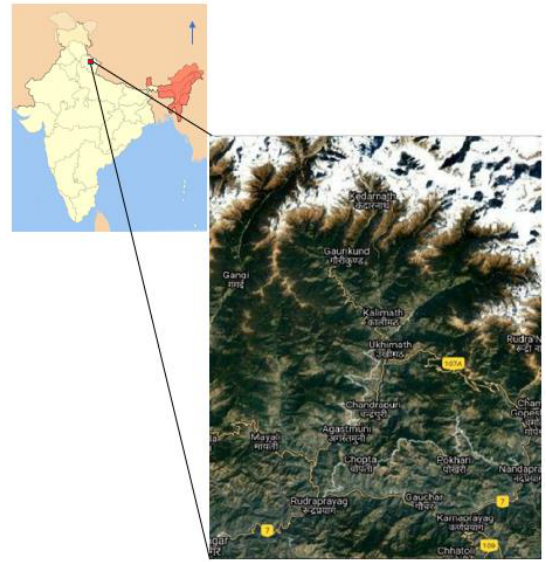
Figure 1. Google Earth Image of Study Area